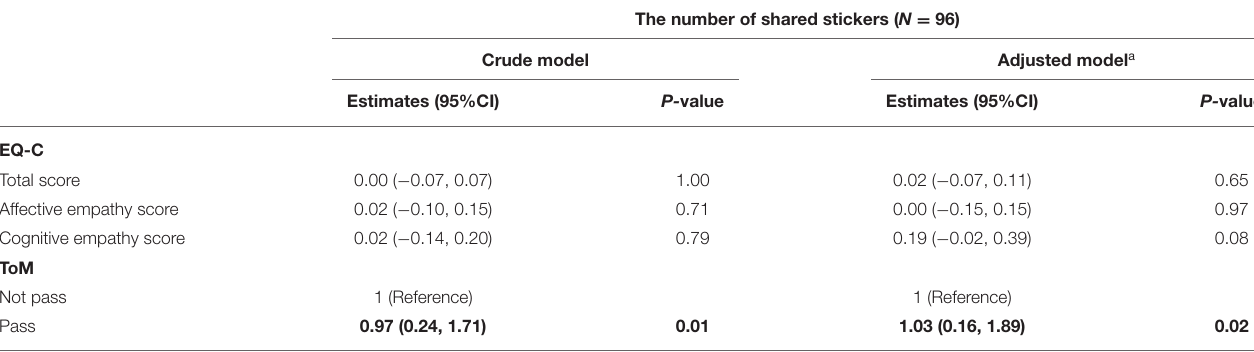
TABLE 3 | Associations between empathic traits, ToM ability and DG paradigm in autistic